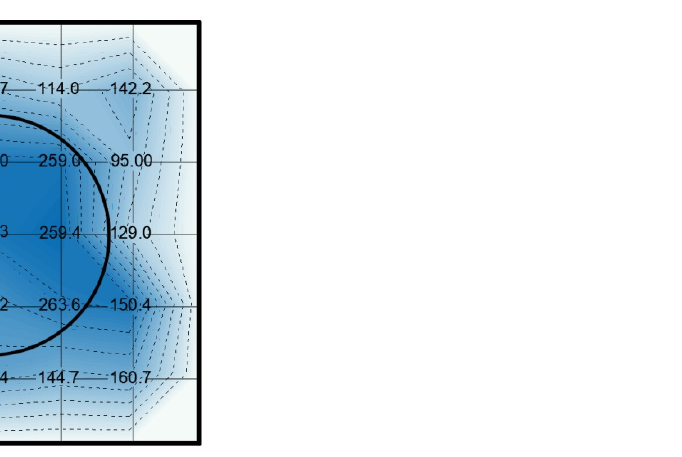
Figure 8. Example of spatial distribution of d 33 constant in a sample charged with a glass dielectric layer with a maximum of 277 pC/N. The numbers indicate the value of the d 33 constant in the measurement points and the circle the position of the high-voltage electrode.